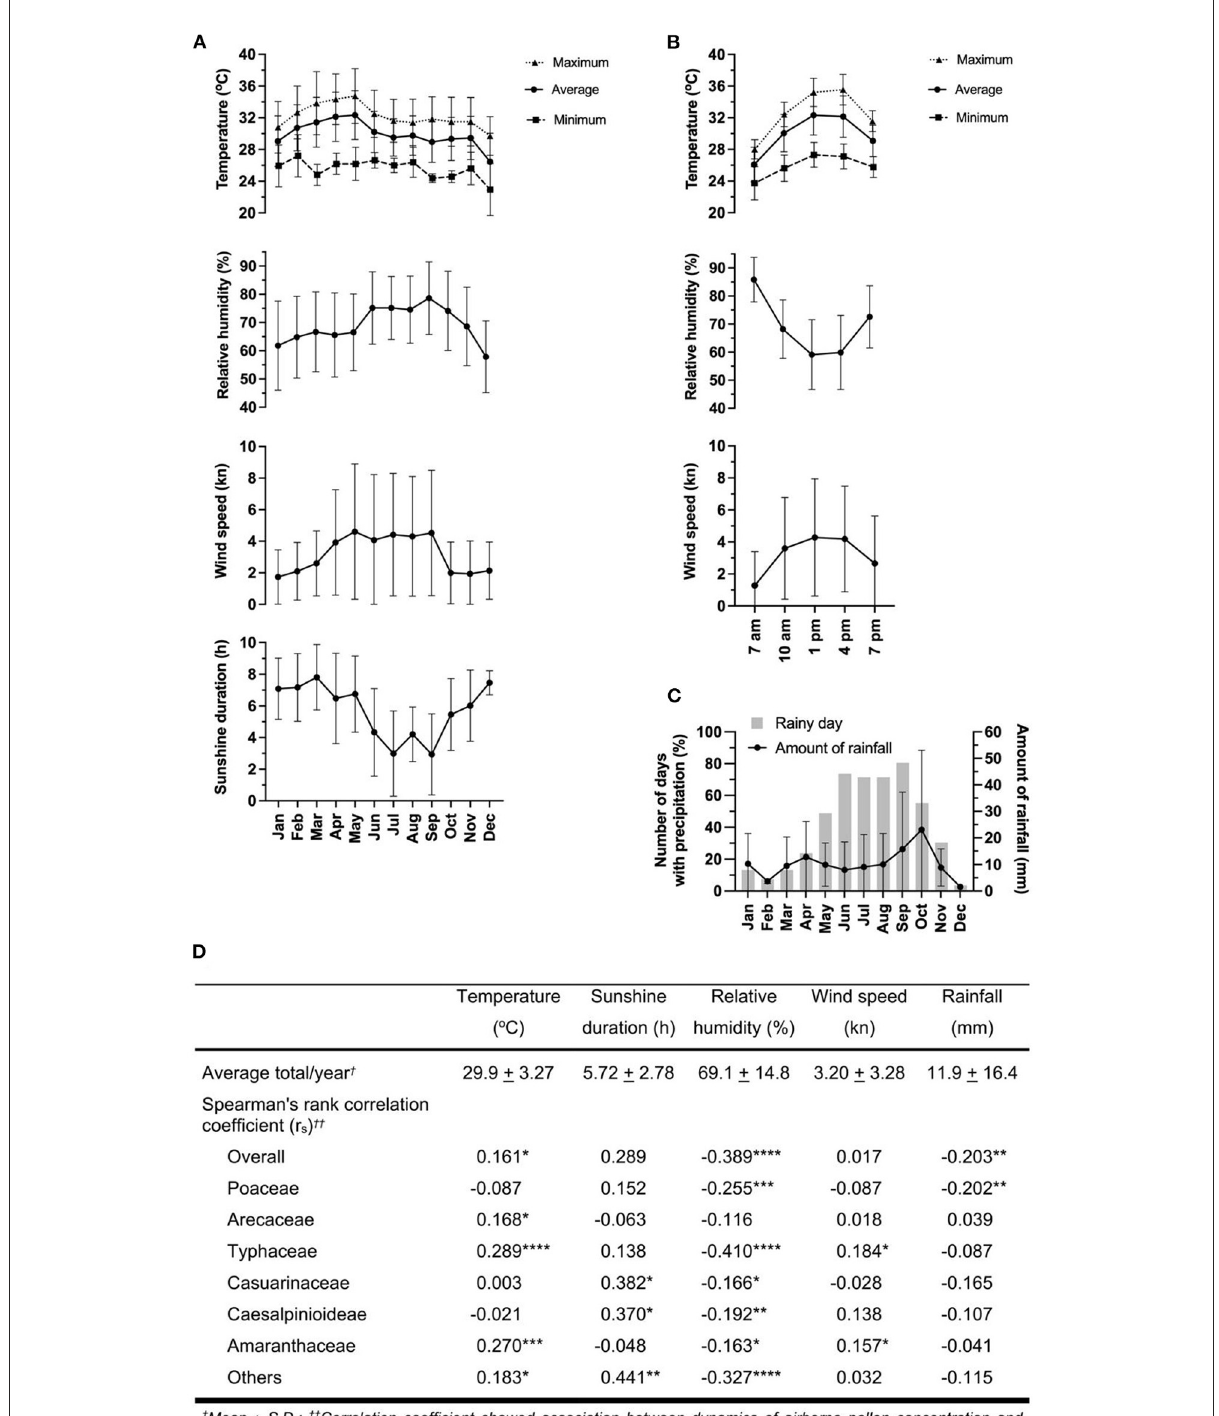
FIGURE5 Meteorological data, total pollen concentration and their correlation. Meteorological records by (A) month and (B) time of collections including temperature, relative humidity, wind speed, and sunshine duration. (C) Amount of rainfall and number of days with precipitation. (D) Correlation analysis of meteorological variations and atmospheric pollen concentrations using Spearman’s rank correlation at a significant level of 0.05. Error bars represent standard deviation